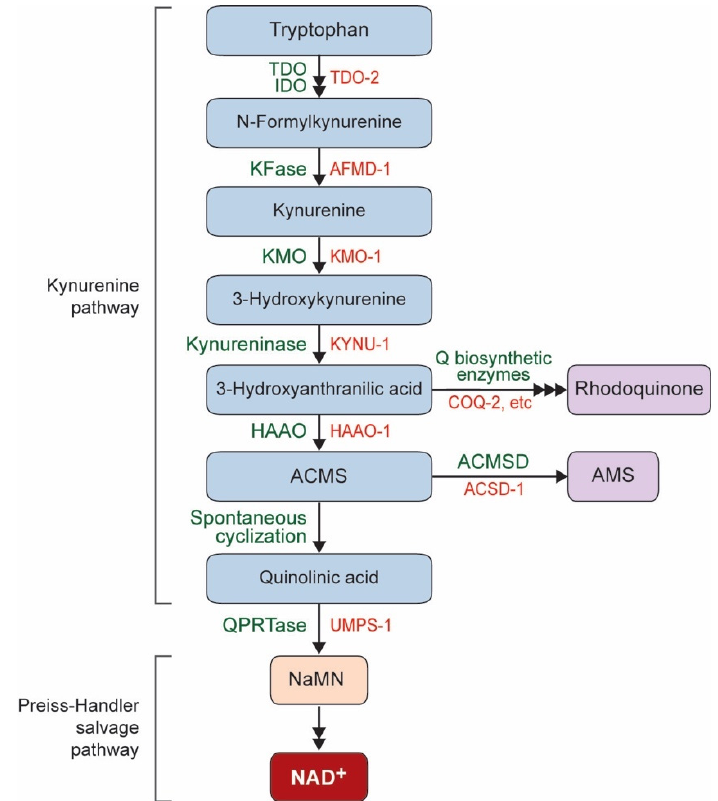
Figure 1. The de novo Nicotinamide adenine dinucleotide (NAD + ) biosynthesis pathway starts with the degradation of the essential amino acid tryptophan via the kynurenine pathway and produces quinolinic acid, which merges with the Preiss–Handler salvage pathway and produces NAD + . TDO, Tryptophan-2,3-dioxygenase; IDO, Indoleamine-2,3-dioxygenase; KFase, Kynurenine formamidase; KMO, Kynurenine-3-monooxygenase; HAAO, 3-hydroxyanthranilate 3,4-dioxygenase; ACMS, α -amino- β -carboxymuconate- ε -semialdehyde; AMS, α -aminomuconate semialdehyde; ACMSD, ACMS decarboxylase; QPRTase, QA phosphoribosyltransferase. Green text: general enzyme names or events; red text: C. elegans genes encoding corresponding enzymes.